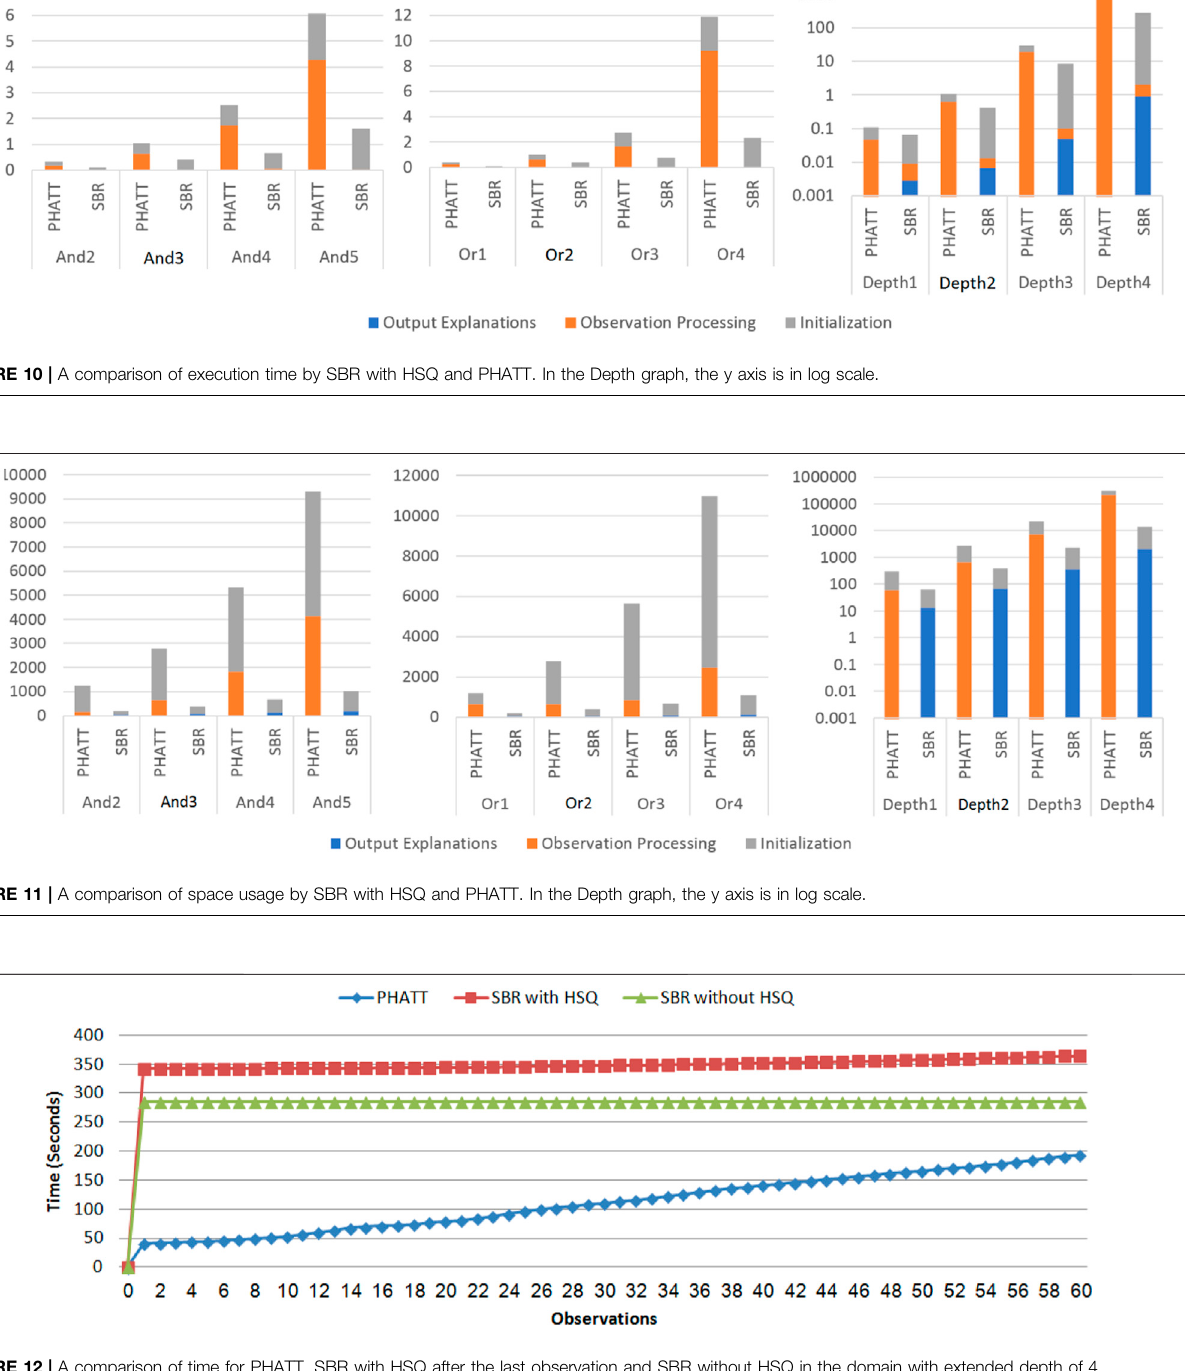
FIGURE 12 | A comparison of time for PHATT, SBR with HSQ after the last observation and SBR without HSQ in the domain with extended depth of